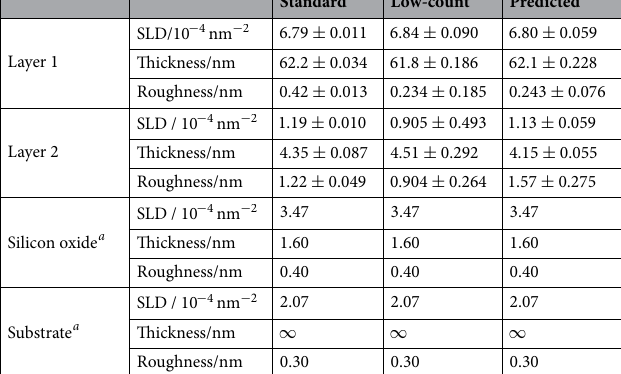
Table 2. Fitting results for the raw and predicted NR data. a Fixed values in the fitting procedure.